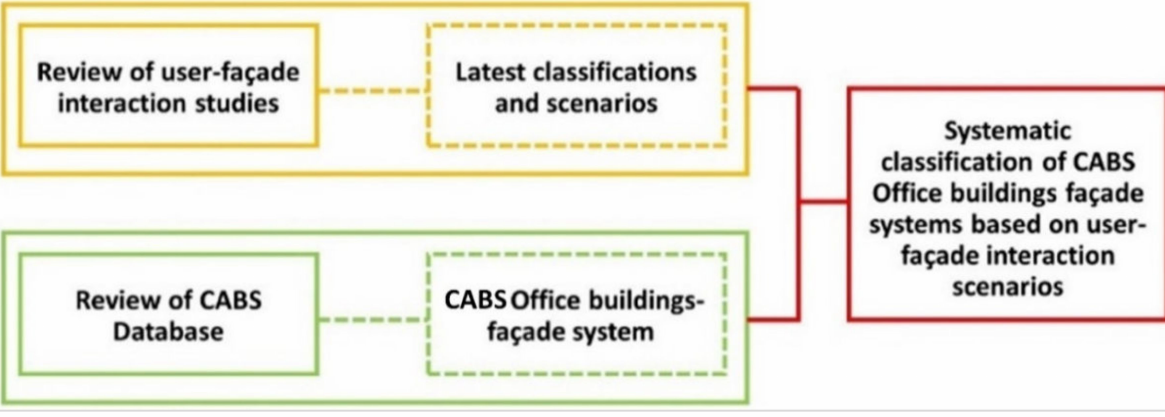
Figure 3. Aim of the research (Authors,